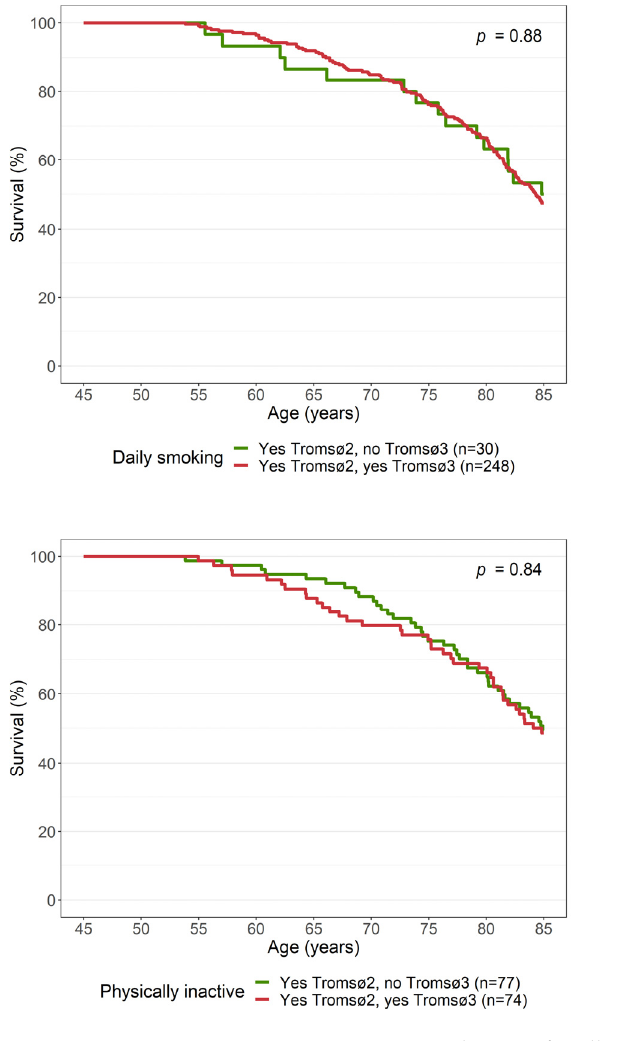
Figure 4. Survival curves for all-cause mortality according to change in daily smoking and physical inactivity. The Tromsø Study 1979–2019. Table 3. Hazard ratios for all-cause mortality from a multiple Cox model. The Tromsø Study 1979–2019.